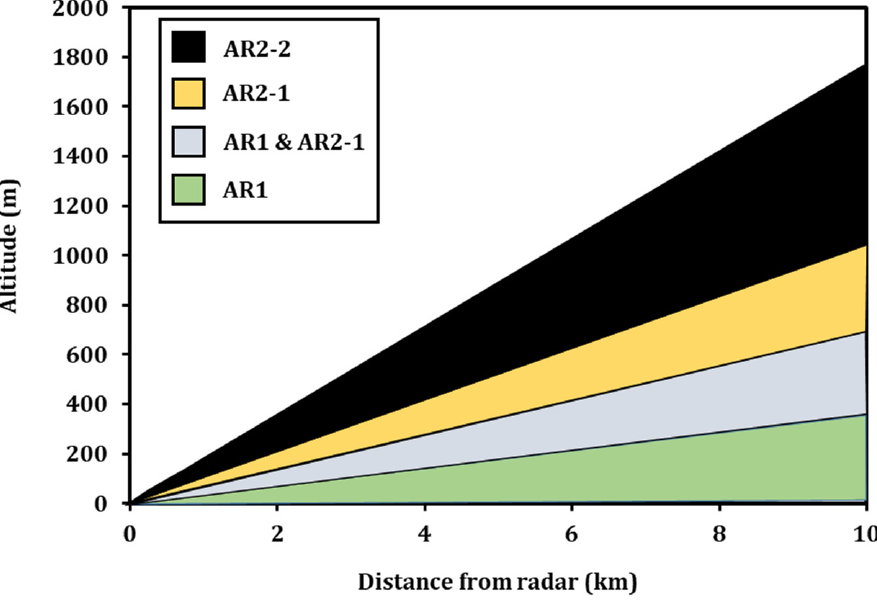
Figure 2. Graphical representation of the beam geometry of the AR1, AR2-1, and AR2-2 radar sen- sors used during a study at Chicago’s O’Hare International Airport, USA, during September 2010– May 2014.